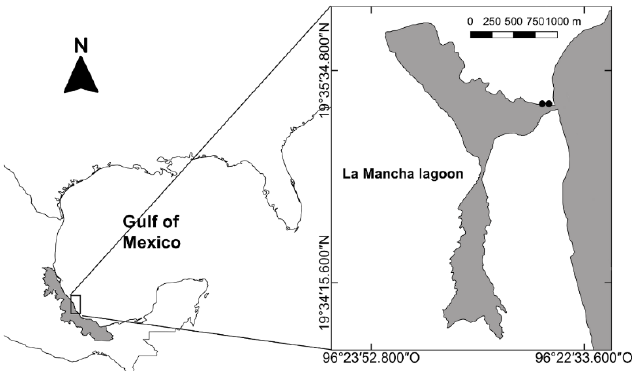
Figure 1. Geographical location of La Mancha lagoon and sampling points (black circles).